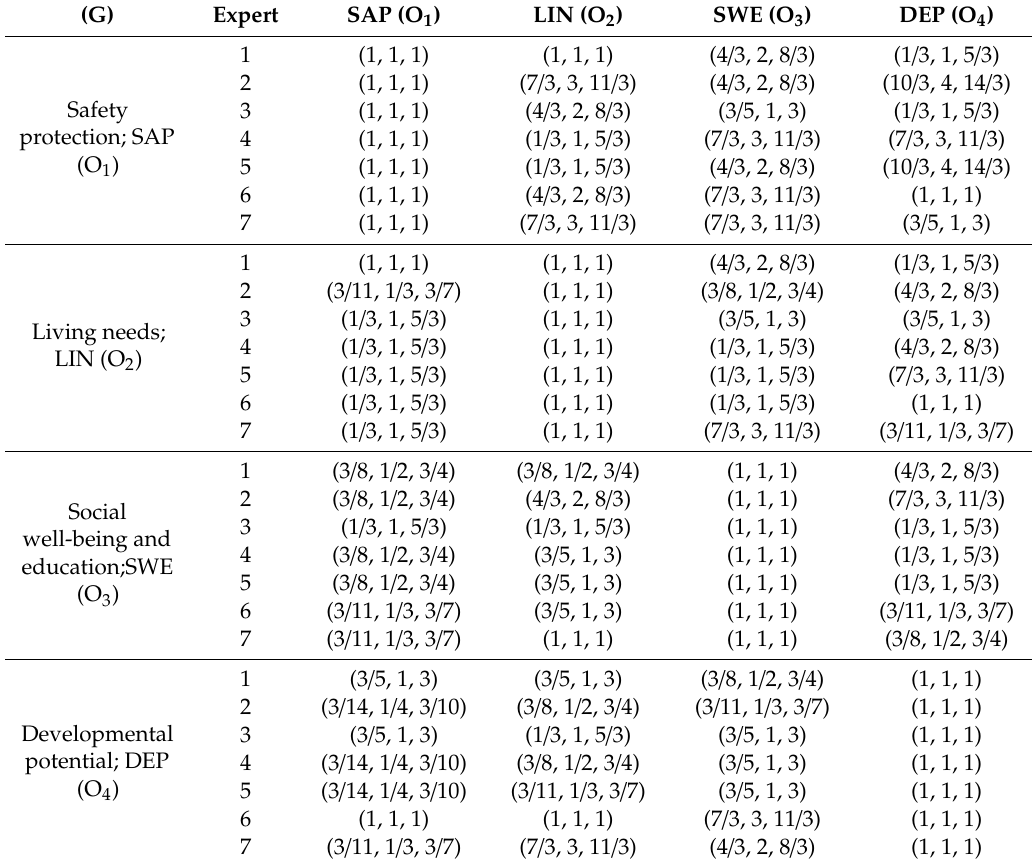
Table 4. The fuzzy pairwise comparison values (seven experts) of objectives with respect to